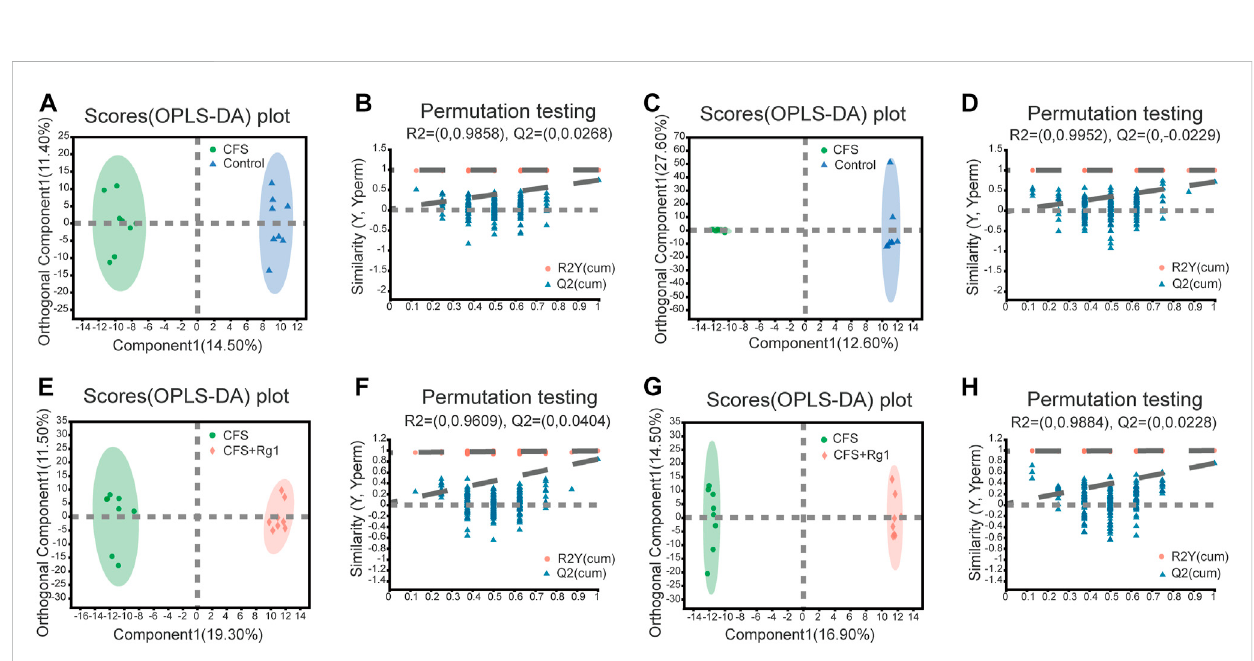
FIGURE 3 OPLS-DA and permutation tests in the positive (A, B) and negative (C, D) ion modes of Control and CFS groups, n = 8. OPLS-DA and permutation tests in positive (E, F) and negative (G, H) ion modes in CFS and CFS + Rg1 groups, n = 8.